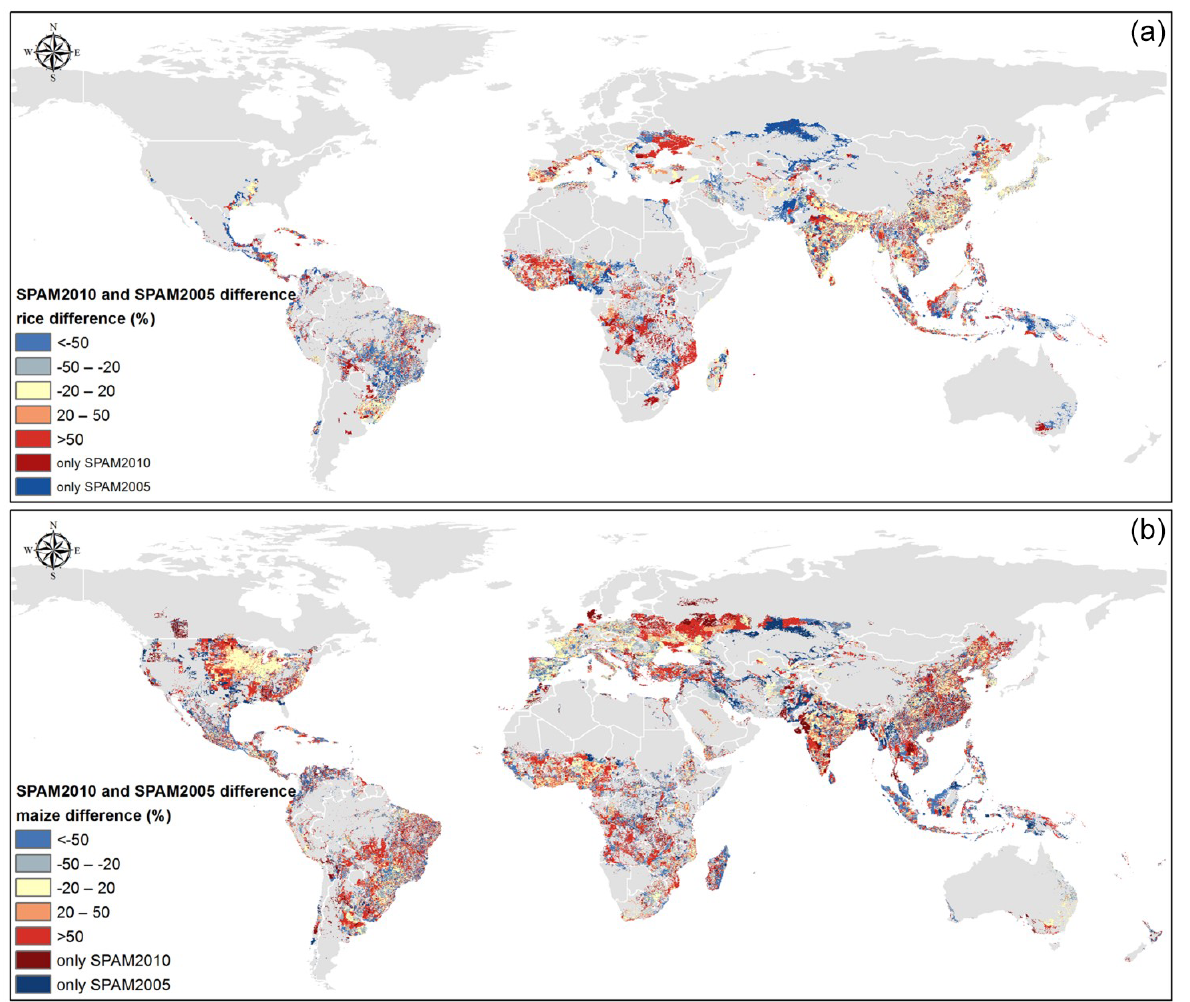
Figure 13. Comparison between SPAM2010 and SPAM2005: (a) relative difference in rice production, (b) relative difference in maize production.